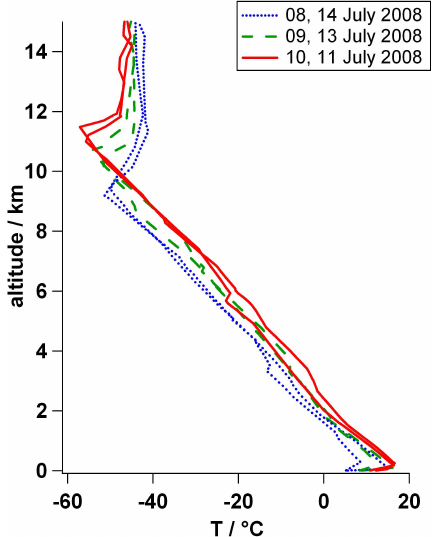
Fig. 7. Temperature profiles at Eureka, Canada (79.98 ◦ N, 85.95 ◦ W) as derived from radiosonde soundings on several days, each at 00:00UTC (taken from http://weather.uwyo.edu/upperair/ sounding.html). The blue dotted lines represent profiles obtained before and after the polluted Asian air mass arrived at Eureka (8 July and 14 July 2008), respectively. The red solid lines show soundings during its passage (10 and 11 July 2008). The green dashed lines represent profiles from times between (9 and 13 July